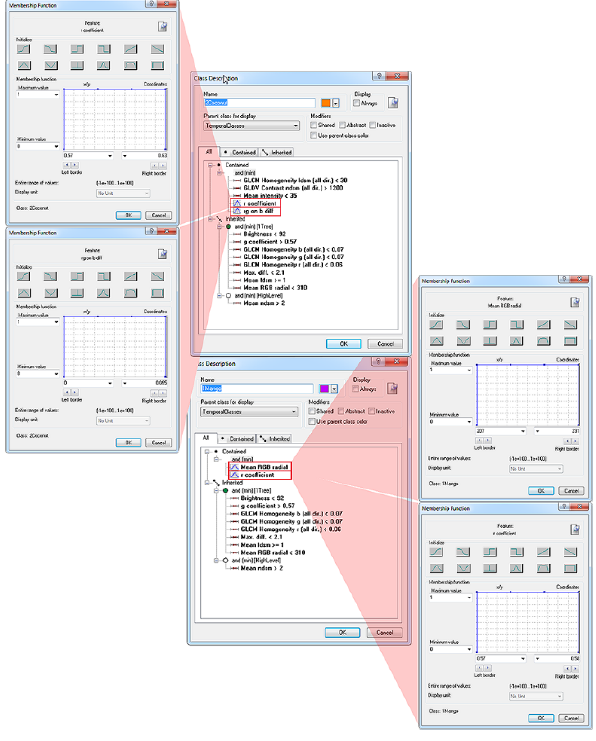
Figure 5. Hierarchal filters embedded in an individual